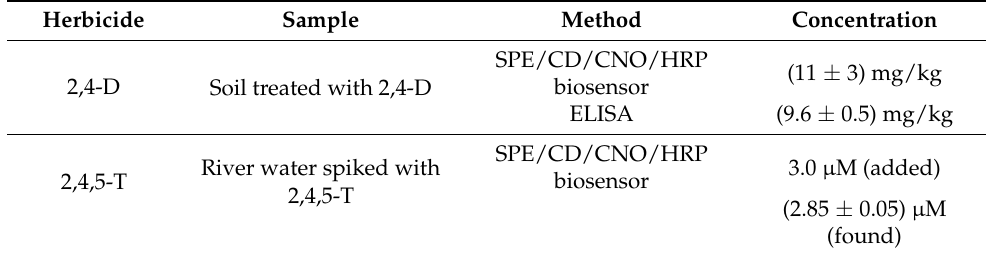
Table 3. Analysis of soil and spiked river water samples.